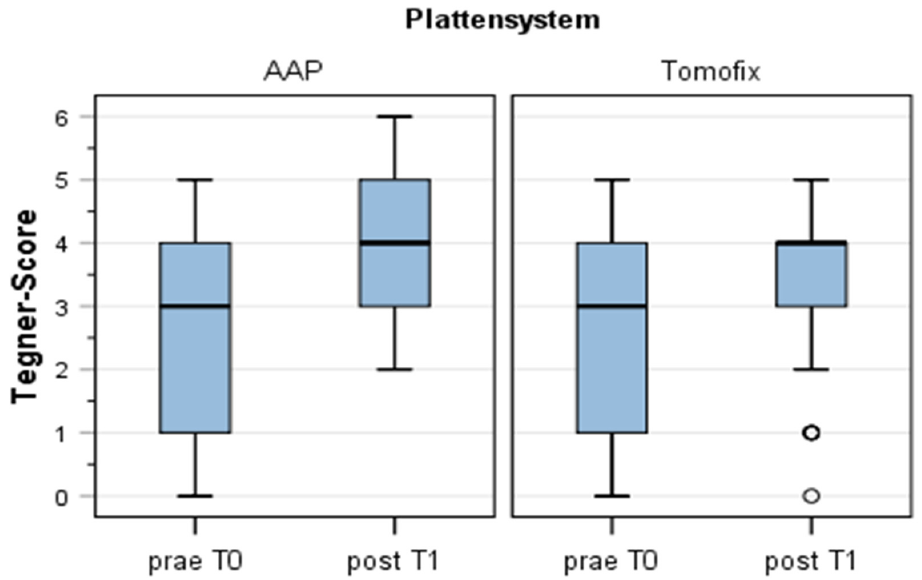
Figure 4. Tegner scale showed no significant difference between the different